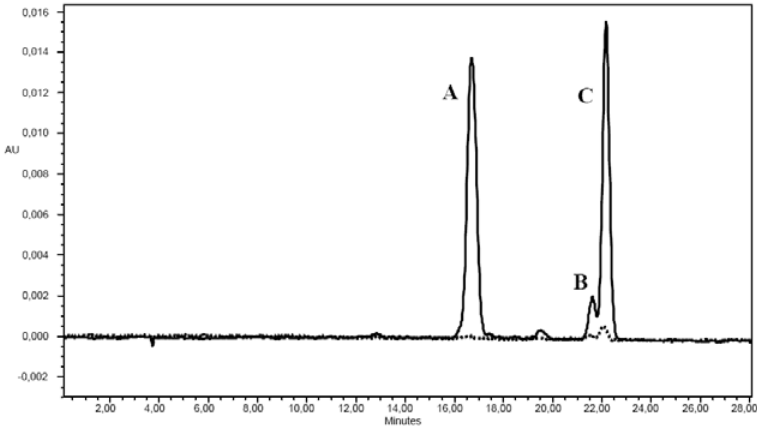
Figure 2. Chromatogram of carotenoids in red ( ___ ) and yellow (----) Solanum indicum L. berries. A: lycopene; B: α -carotene; C: β